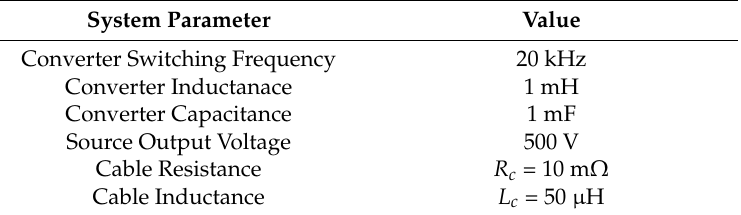
Figure 10. Configuration of the simulated EPS. Table 1. Parameter values used for simulation.